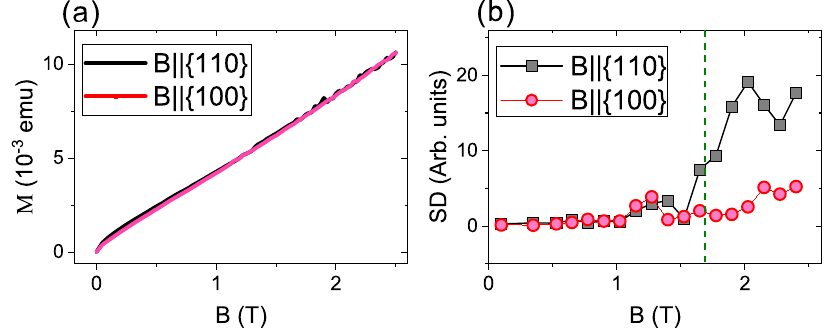
Fig. 5 Magnetization measurements. a Magnetization measurement for both fi eld orientations within the ab -plane. b Standard deviation of the magnetization measurements. Details are discussed in the main